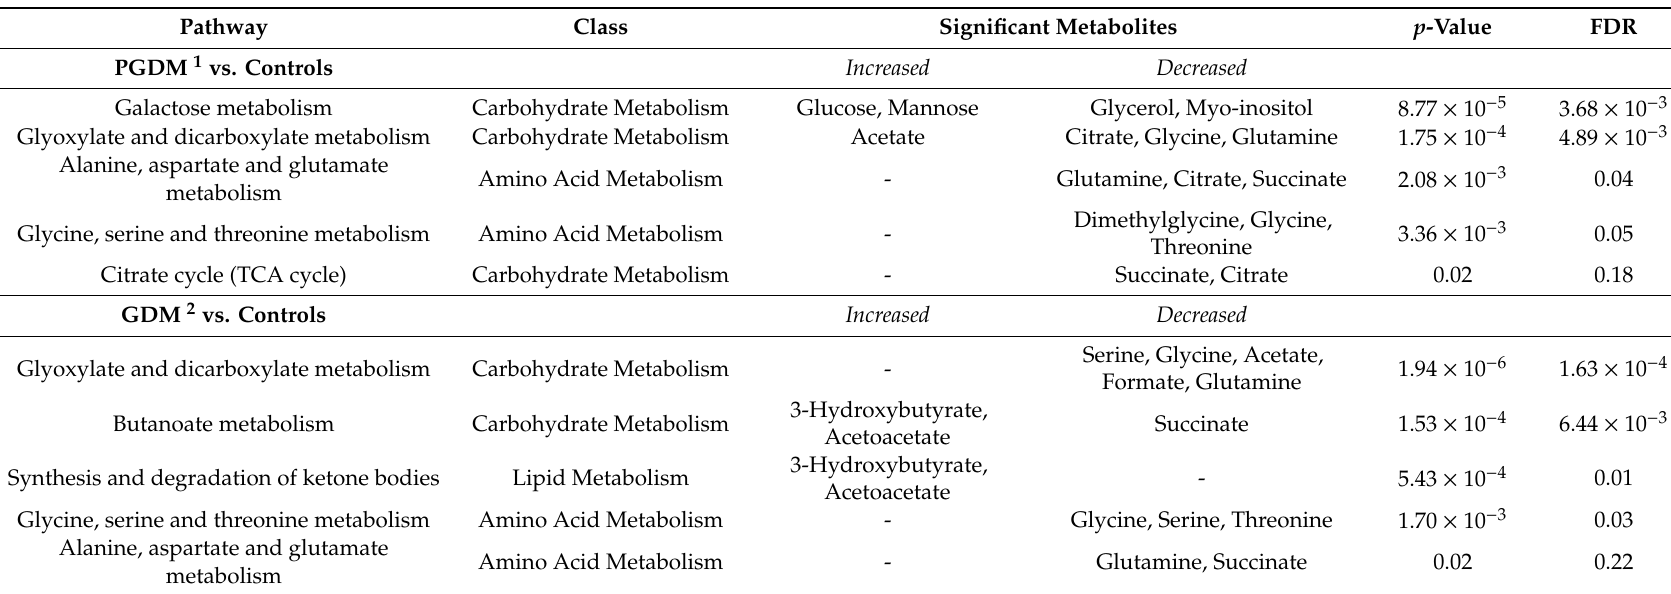
Table 4. Pathways Significantly Altered in Maternal Serum in PGDM or GDM throughout